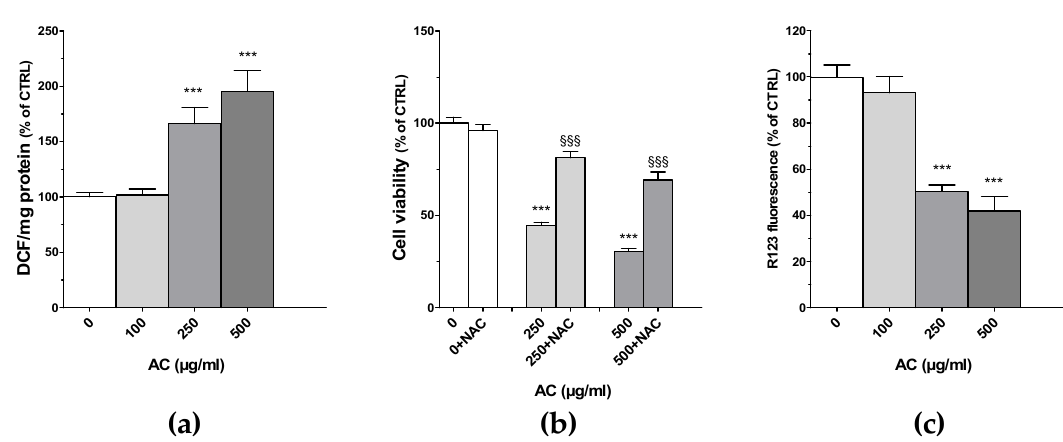
Figure 4. Acacia catechu Willd. extract (AC)-mediated effects on 2 ′ ,7 ′ -dichlorofluorescein’s (DCF) intracellular concentration ( a ); cell viability in the presence of N-acetyl-L-cysteine (NAC) ( b ) and rhodamine 123 (R123) staining ( c ) in human colorectal adenocarcinoma HT-29 cells. NAC (1 mM) was pre-incubated for 2h before the addition of AC (250 or 500 µg/mL). Data are reported as means ± SEMs of at least four independent experiments in which four points/concentrations were run; controls (AC 0 µg/mL) represent untreated cells. *** p < 0.001 vs. controls; §§§ p < 0.01 vs. the same concentration of AC (ANOVA followed by Dunnett post-test).